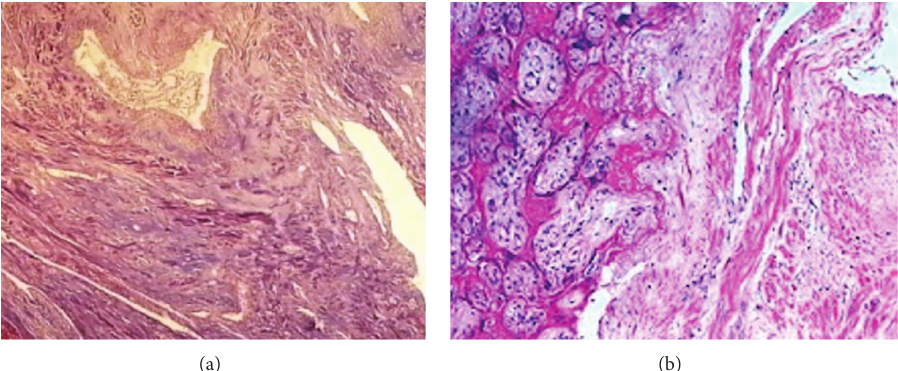
Figure 2: Chorionic villi invading the myometrium were shown with (a) Masson-trichrome staining and (b) hematoxylin-eosin